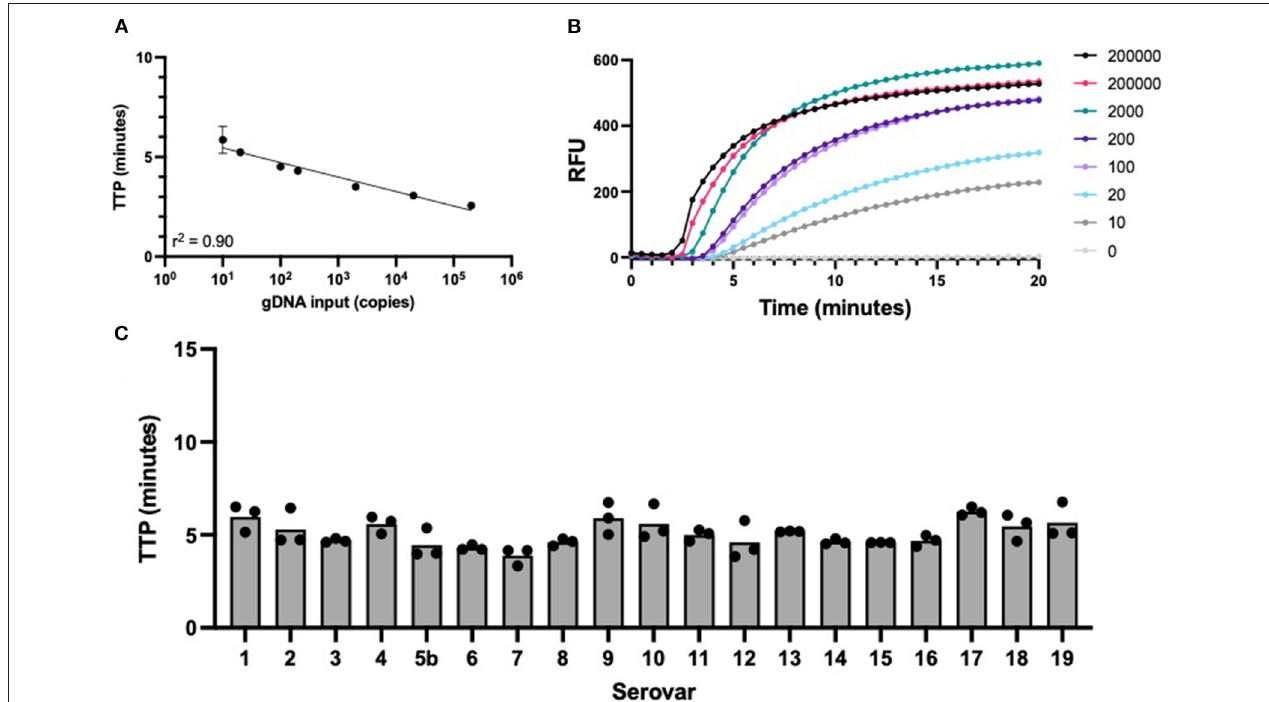
FIGURE 1 | APP-RPA performance. (A) Regression line of APP-RPA limit of detection across 12 replicates using two different template dilutions of serovar 8 reference strain 405. Equating gDNA input to time to positive (TTP). (B) Fluorescence data of the amplification of APP-RPA, calculated from the average relative fluorescence units (RFU) obtained from 12 replicates of APP serovar 8. (C) TTP of all known serovars of APP reference strains amplified in APP-RPA at 200 copies/ µ L.